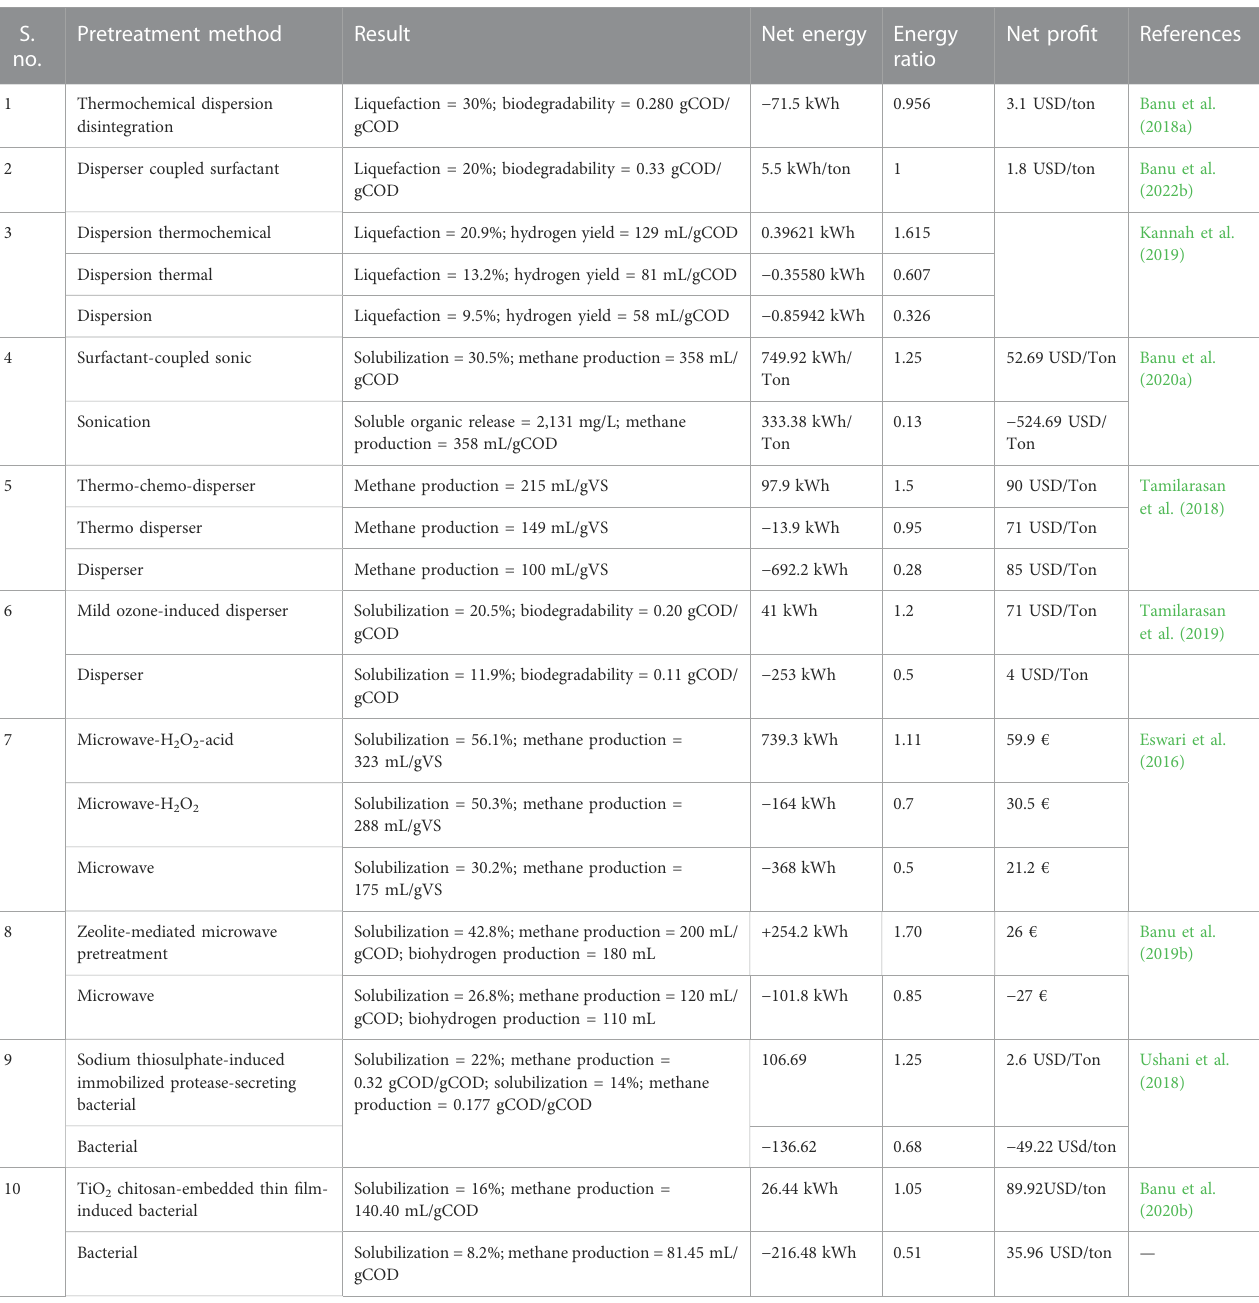
TABLE 2 Cost and energy analysis of various pretreatment methods. S.